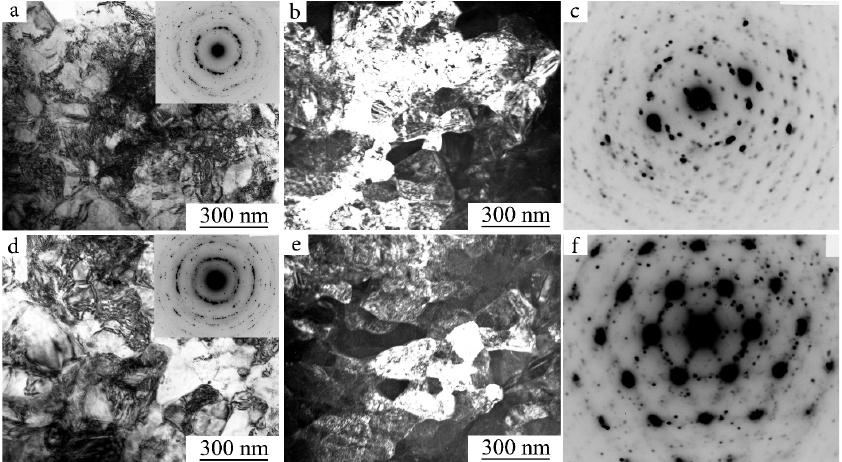
Figure 21. ( a , d ) Bright- and ( b , e ) dark-field TEM images of the microstructure, and (( c )—z.a. [110] R , ( f )—z.a. [110] B 19′ and z.a. [111] R ) the corresponding SAED patterns (SD 0.3 µm), from the Ti 49.5 Ni 50.5 alloy after ( a – c ) MPR, 30% + 773 К , 1 h and ( d – f ) MPR, 30% + 873 К , 1 h. SAED patterns in inserts ( f )—z.a. [110] B 19 (cid:48) and z.a. [111] R ) the corresponding SAED patterns (SD 0.3 µ m), from the Ti 49.5 Ni 50.5 ( a ) and ( d ) were obtained by SD 1.0 µm. alloy after ( a – c ) MPR, 30% + 773 K, 1 h and ( d – f ) MPR, 30% + 873 K, 1 h. SAED patterns in inserts ( a ) and ( d ) were obtained by SD 1.0 µ